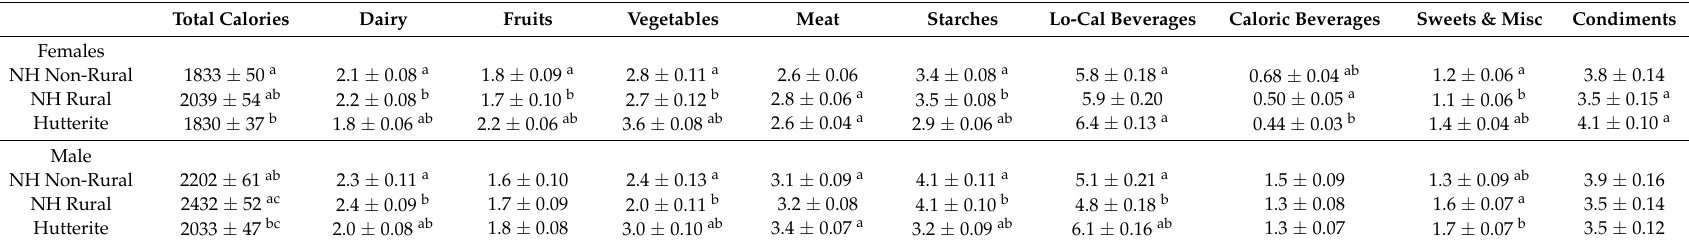
Table 3. Marginal means ( ± SE) of servings by food groups.